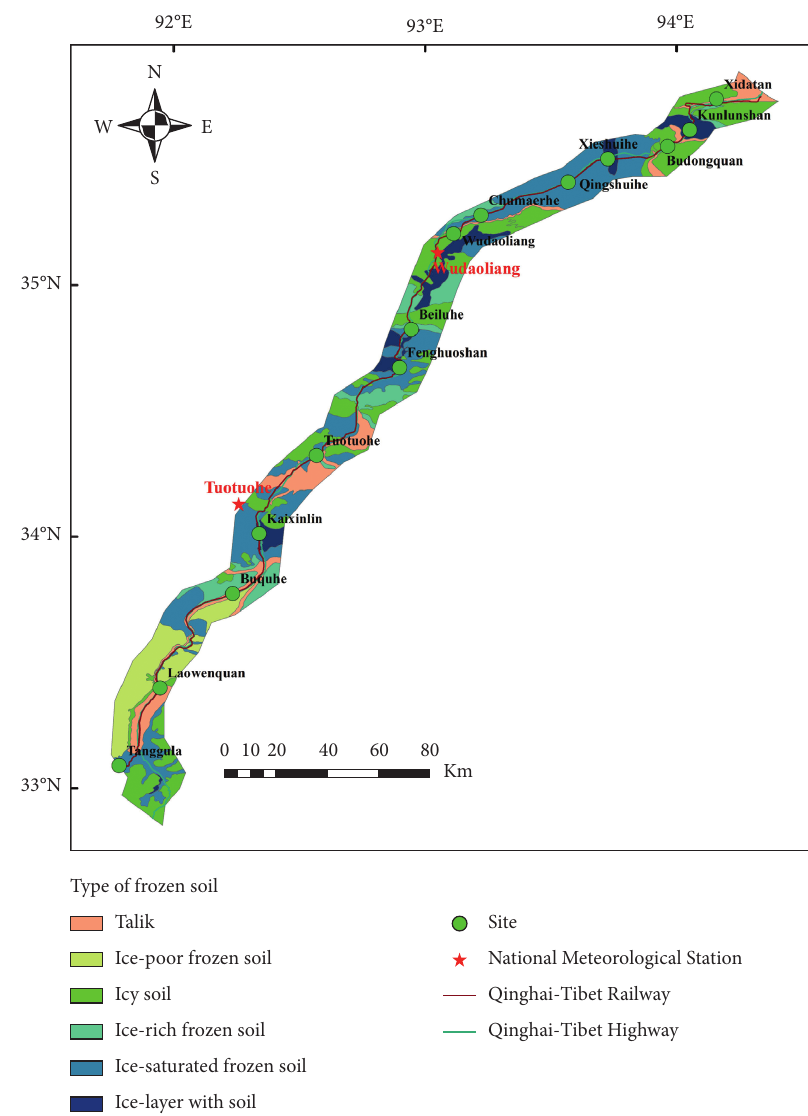
Figure 2: Types of frozen soil along the QTEC (source: reproduced with permission from Chai 2018, a coauthor of this study. Copyright 2018 Journal of Cold Regions Engineering).